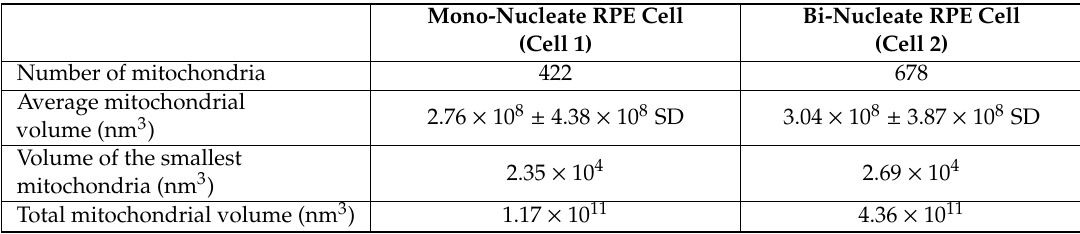
Table 2. Measurements of mitochondria from 3D-recontructed RPE